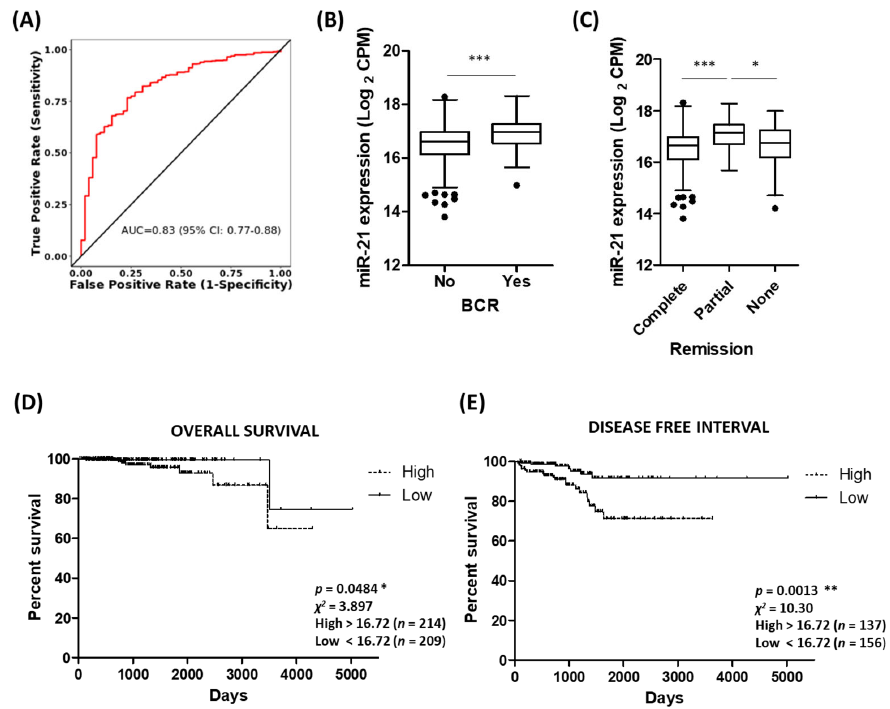
Figure 5. Potential of miR-21 as a biomarker of prostate cancer. ( A ) ROC curve analysis demonstrating that miR-21 shows high potential for distinguishing between tumour and normal tissue. Analysis performed using CancerMIRNome based on PRAD cohort in TCGA database. ( B ) Biochemical recurrence is associated with significantly high levels of miR-21 ( n , no recurrence = 406, recurrence = 61). (Welch’s t -test, *** p < 0.001.) ( C ) Significant difference in miR-21 levels between patient remission response after primary therapy ( n , complete = 380, partial = 41, none (stable or progressive disease) = 58.) (One-way ANOVA with multiple comparison tests, * p < 0.05, *** p < 0.001.) KM survival curves show high levels of miR-21 significantly associated with ( D ) decreased overall survival and ( E ) reduced disease-free interval. (Both log-rank (Mantel–Cox) test, * p < 0.05, ** p < 0.01.) Data analysis for B to E was performed using UCSC Xena based on PRAD cohort in TCGA database. All boxplots show mean and Tukey